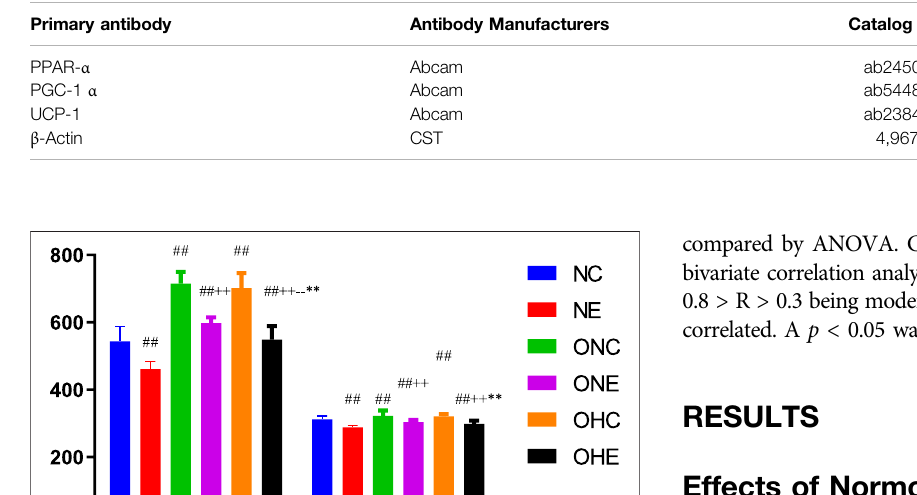
TABLE 2 | Dilution ratio of primary antibodies.